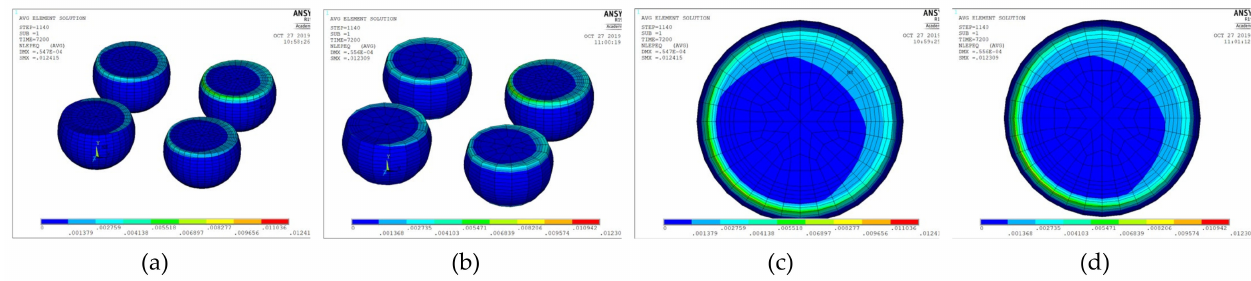
Figure 14. Equivalent inelastic strain distribution: ( a ) Full fine-mesh model; ( b ) MPC model; ( c ) maximum strain in the full model (top view); ( d ) maximum strain in the MPC model (top view).